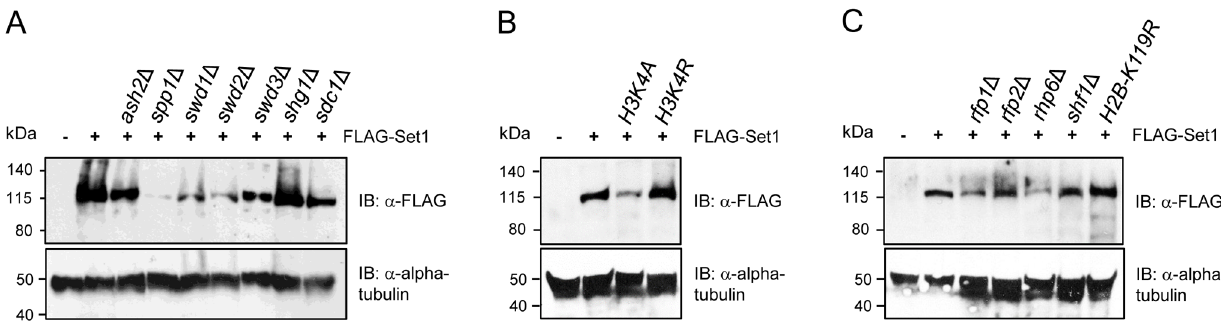
Figure 4. Stability of Set1 proteins is uncoupled from the status of H3K4me and H2Bub. Set1 proteins containing an N-terminal FLAG epitope were analyzed by immunoblotting (IB) in cells deficient in (A) individual components of Set1C, (B) histone H3K4 mutants, or (C) HULC/H2Bub mutants. Alpha tubulin (loading control) was detected by anti-tubulin antibody (tat-1).